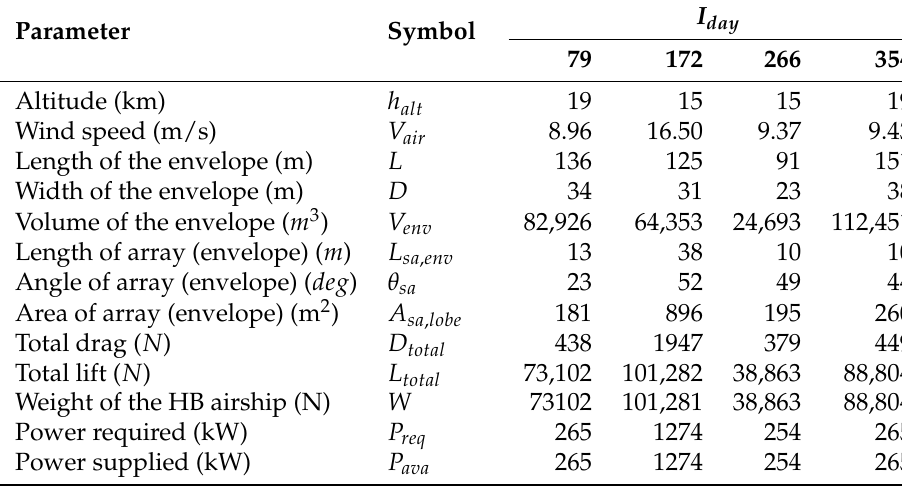
Figure 17. Optimum configurations—conventional airship. Table 8. Key output